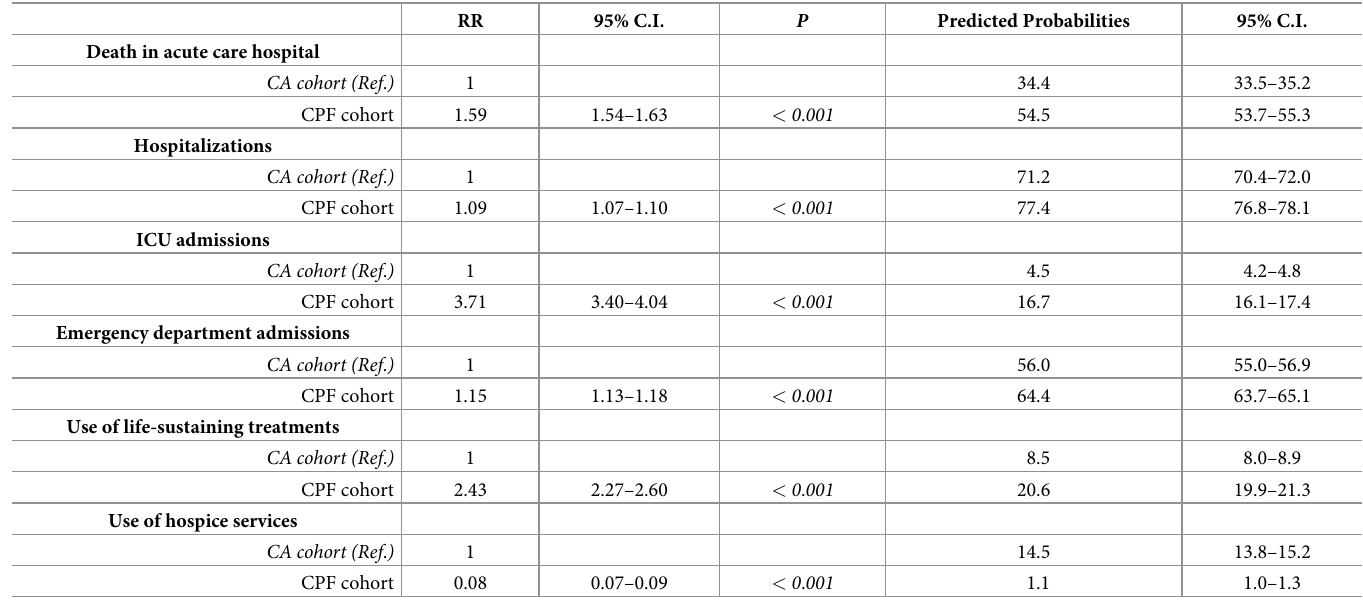
Table 3. Summary of the results obtained from the multivariable